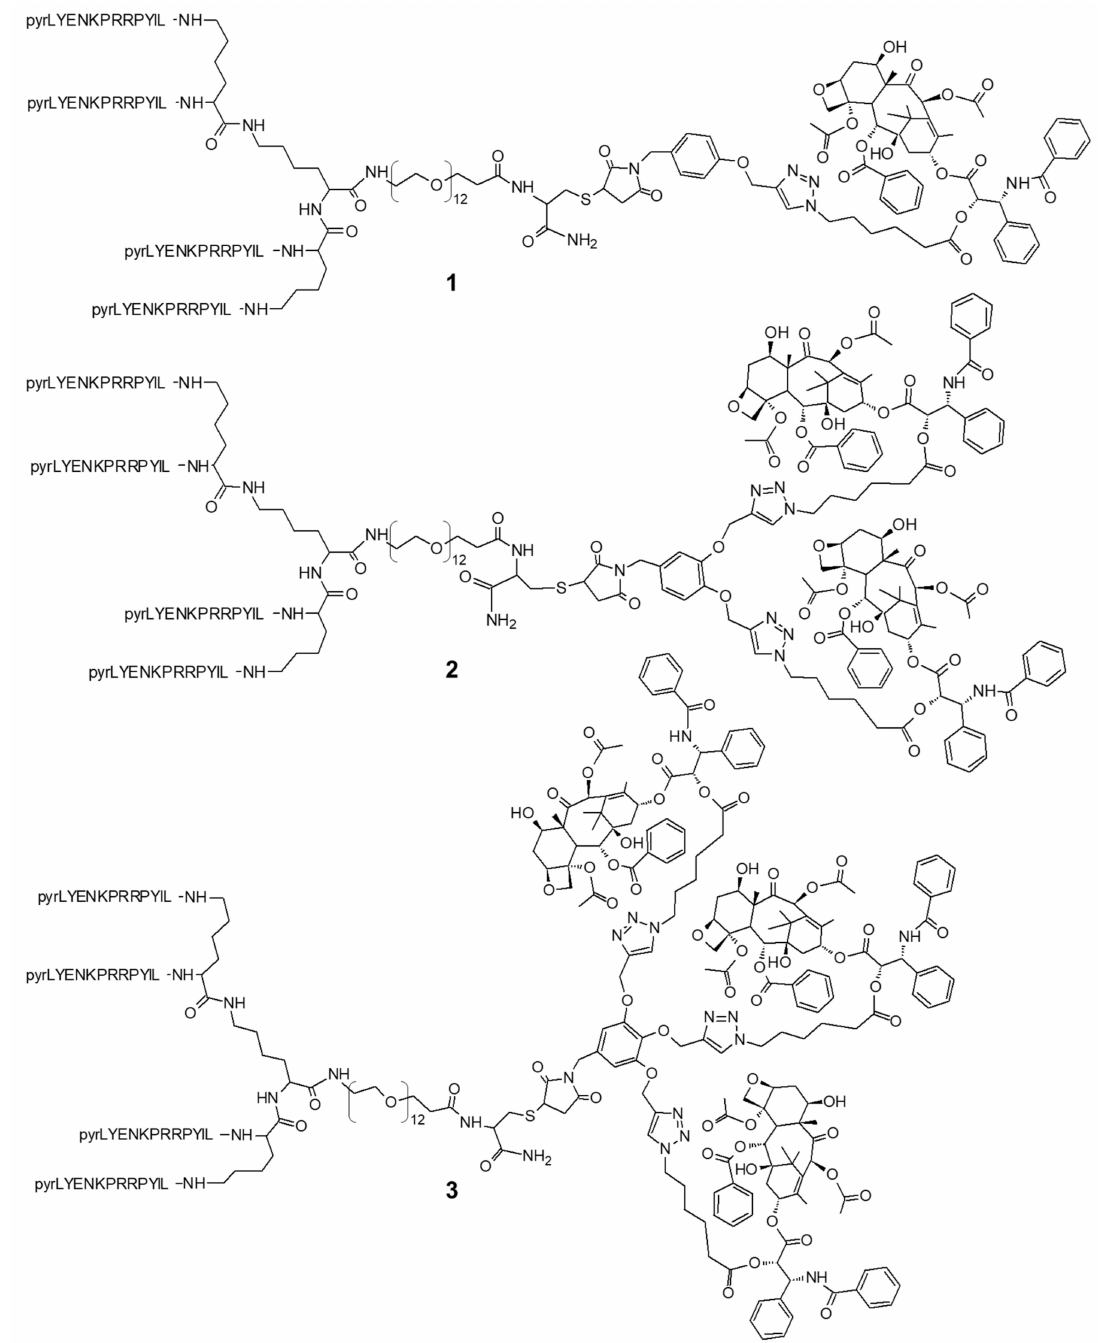
Figure 1. Structures of NT4-mono PTX ( 1 ), NT4-bis PTX ( 2 ), and NT4-tris PTX ( 3